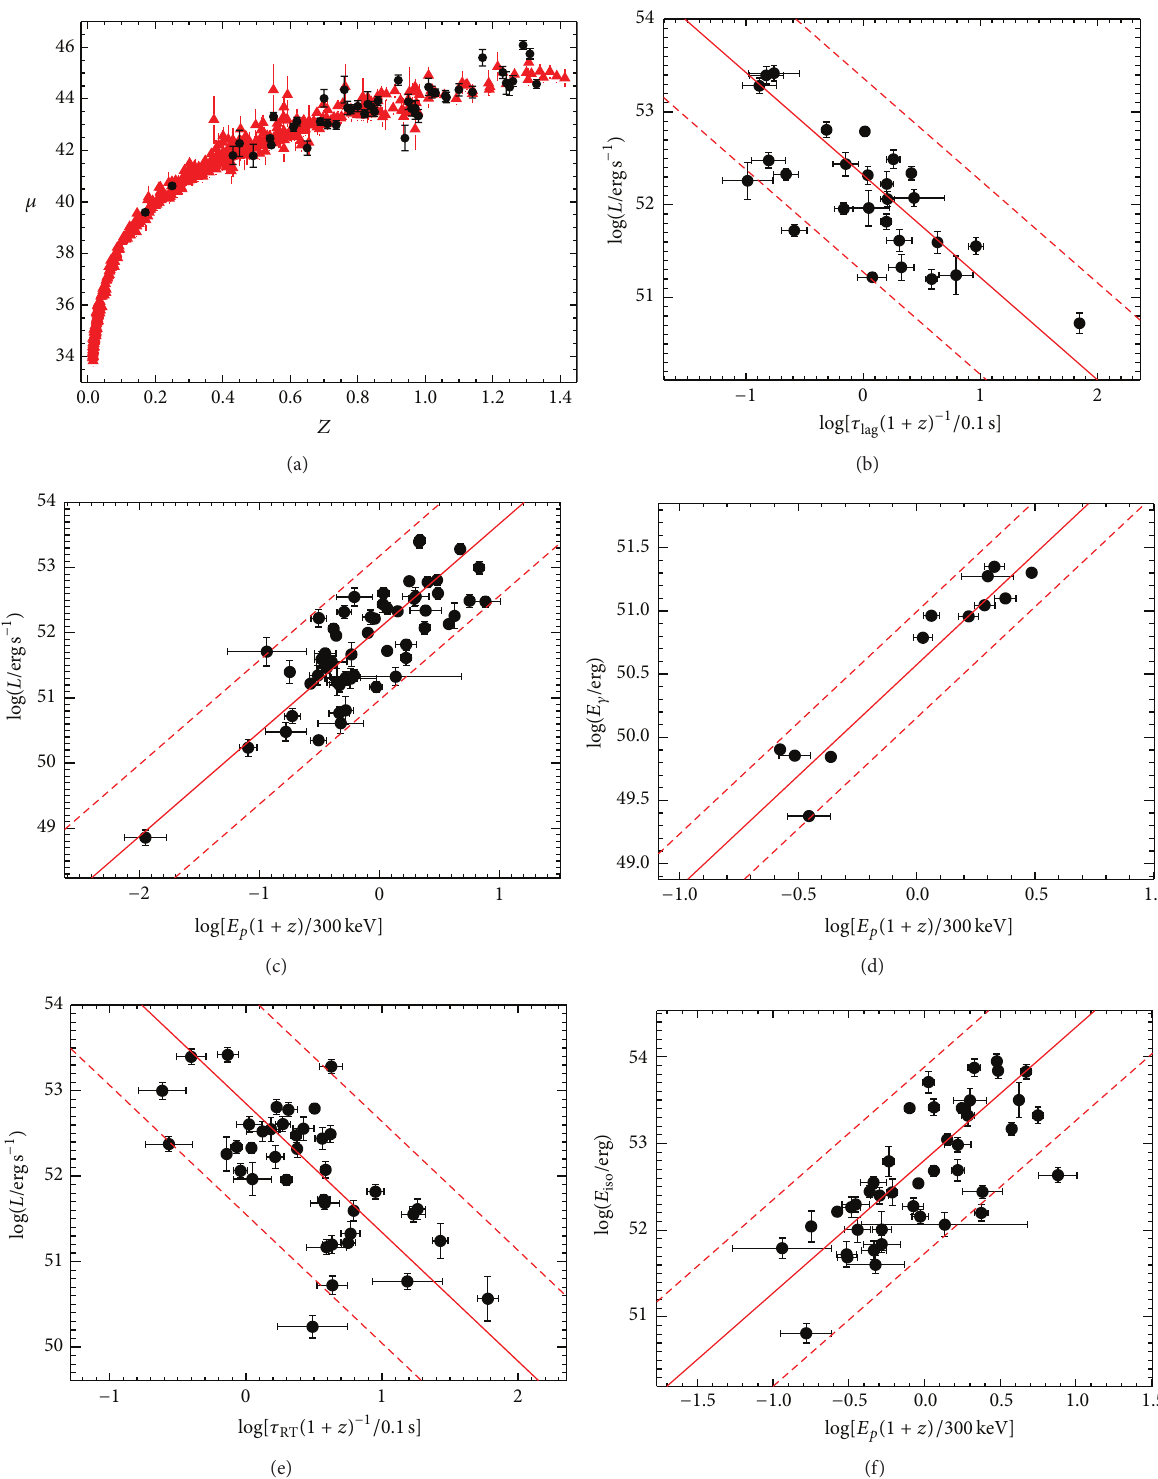
Figure 1: (a) The Hubble diagram of 580 SNe Ia (red triangles) and 57 GRBs at 𝑧 ≤ 1.4 (black dots) whose distance moduli are derived by using cubic spline interpolation. (b)–(f) The 𝜏 with the sample at 𝑧 ≤ 1.4 using cubic spline interpolation. The solid lines show the best-fitting results, while the dashed lines represent their 2𝜎 dispersion around the best